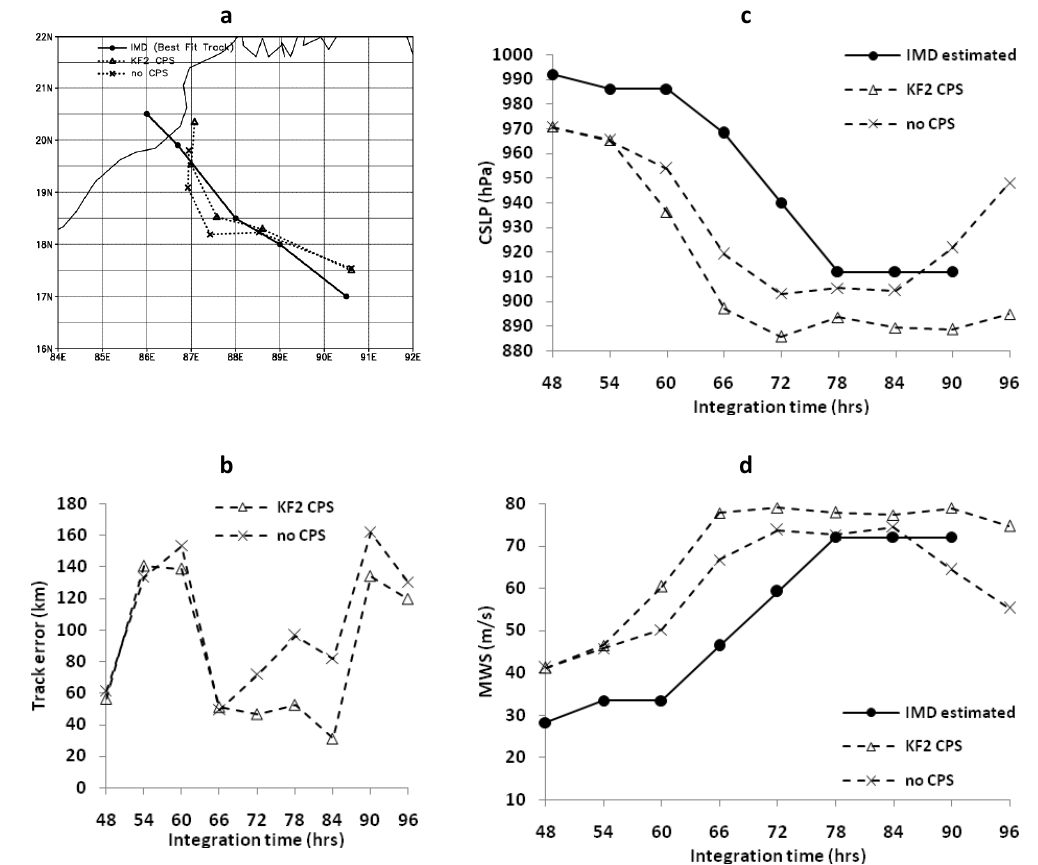
Fig. 6. Same as Fig. 2 but for the experiments of sensitivity to explicit modelling of convection: with CPS of KF2 and without any CPS in the D3 with three-domain configuration(45, 15, 5km